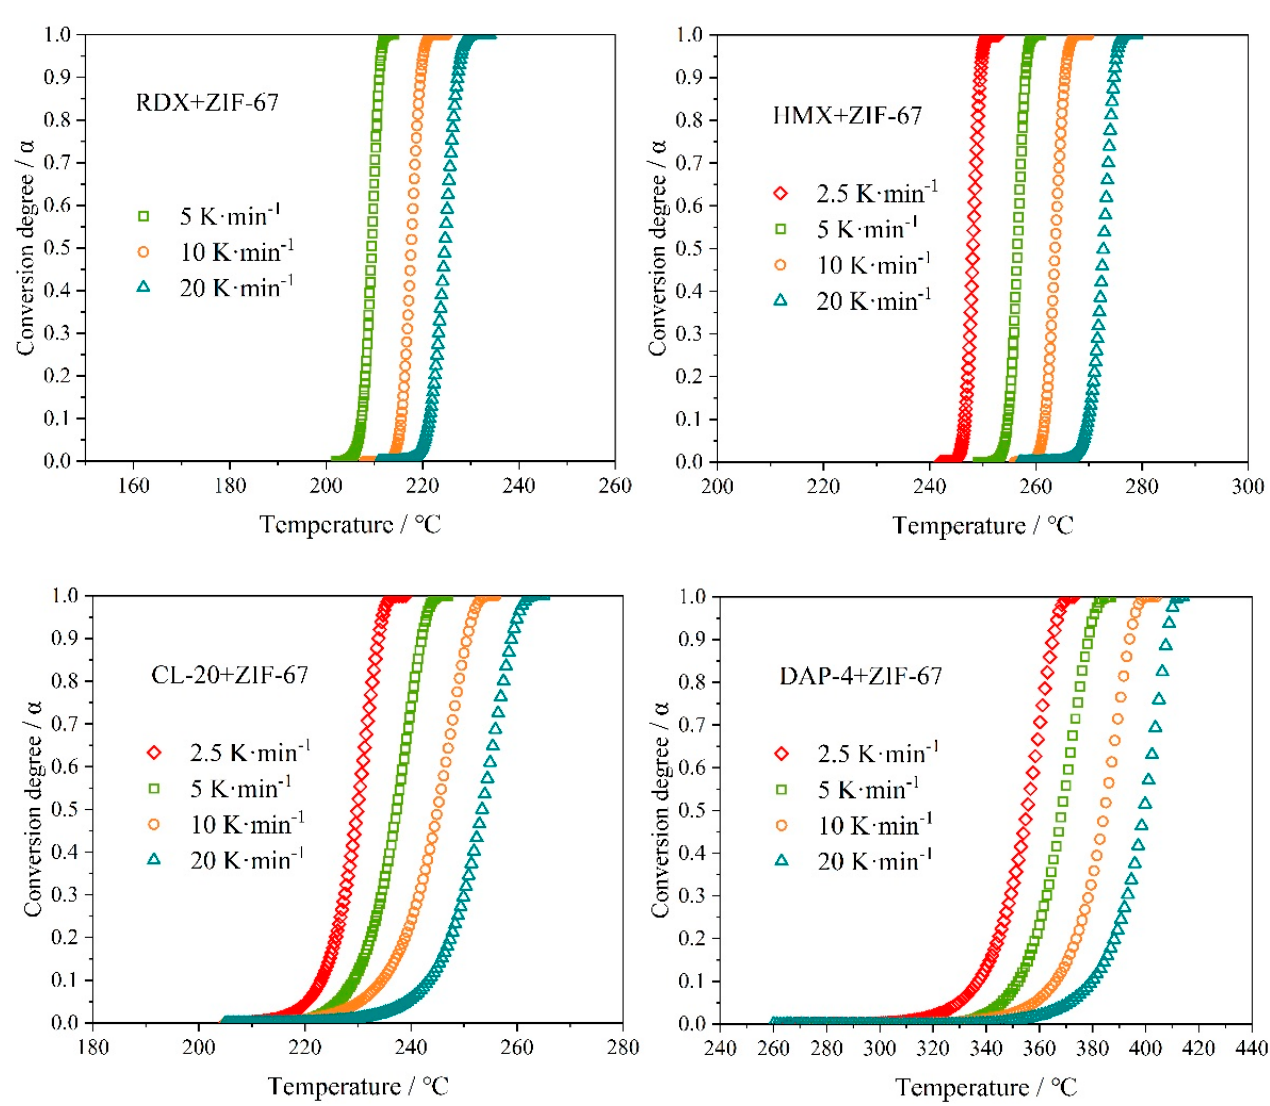
Figure 10. The α -T relationships of four composites.